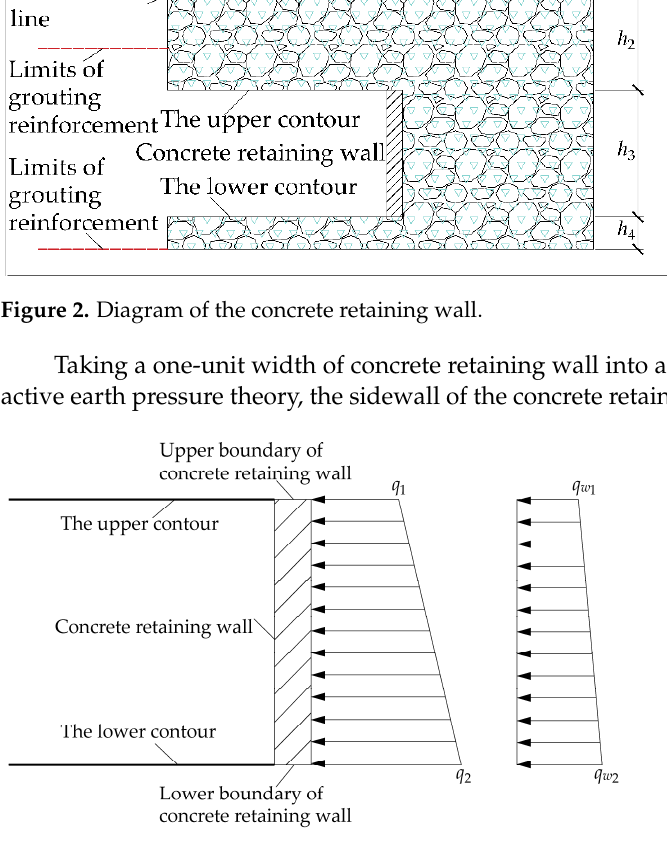
Figure 3. Pressure on the sidewall of the stopper wall.